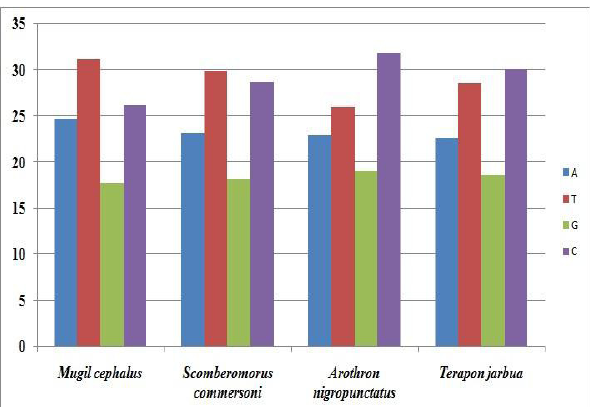
Fig. 1. Nucleotide percentage compositions of CO1 gene in the four fish species